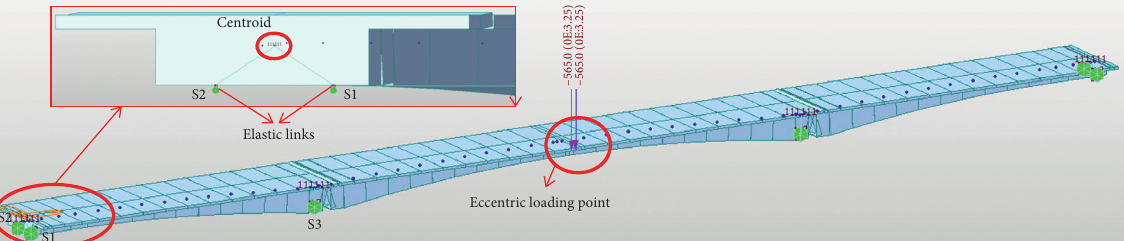
Figure 7: The beam model of the analysis bridge.